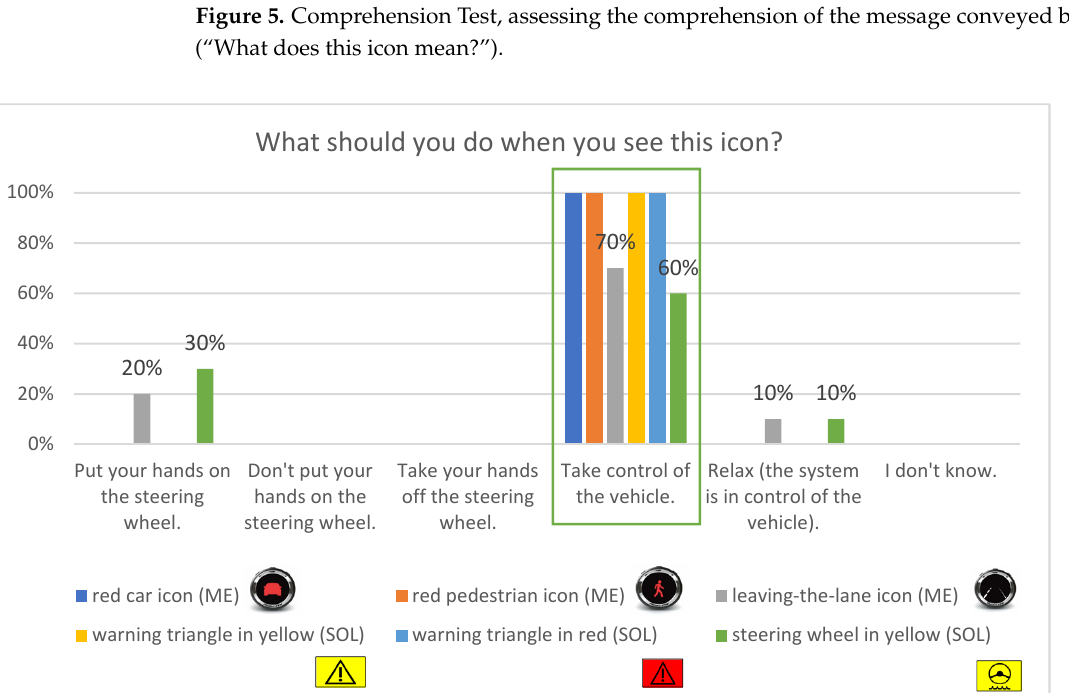
Figure 6. Comprehension Test, assessing the level of understanding of the message conveyed by the icons (“What should you do when you see this icon?”).